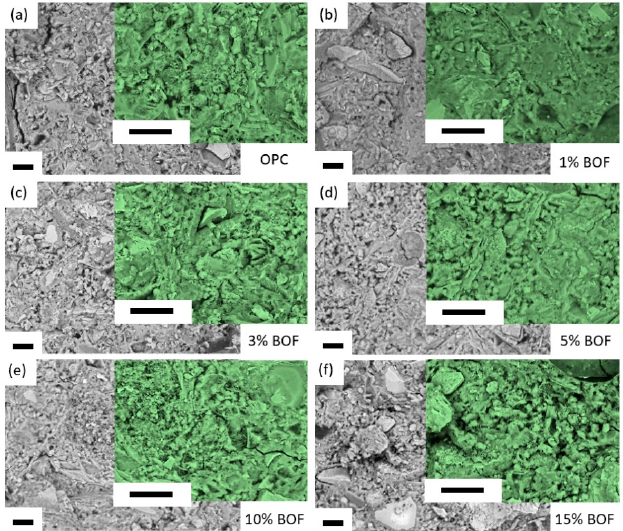
Figure 6. SEM images for ( a ) OPC, as well as BOF-enhanced cement mortar with ( b ) 1% BOF, ( c ) 3% BOF, ( d ) 5% BOF, ( e ) 10% BOF, and ( f ) 15% BOF, at the curing age of 28 days (gray images are the low magnification of 1000×, and green images are the high magnification of 2000×) (all scale bars are 100 µm).